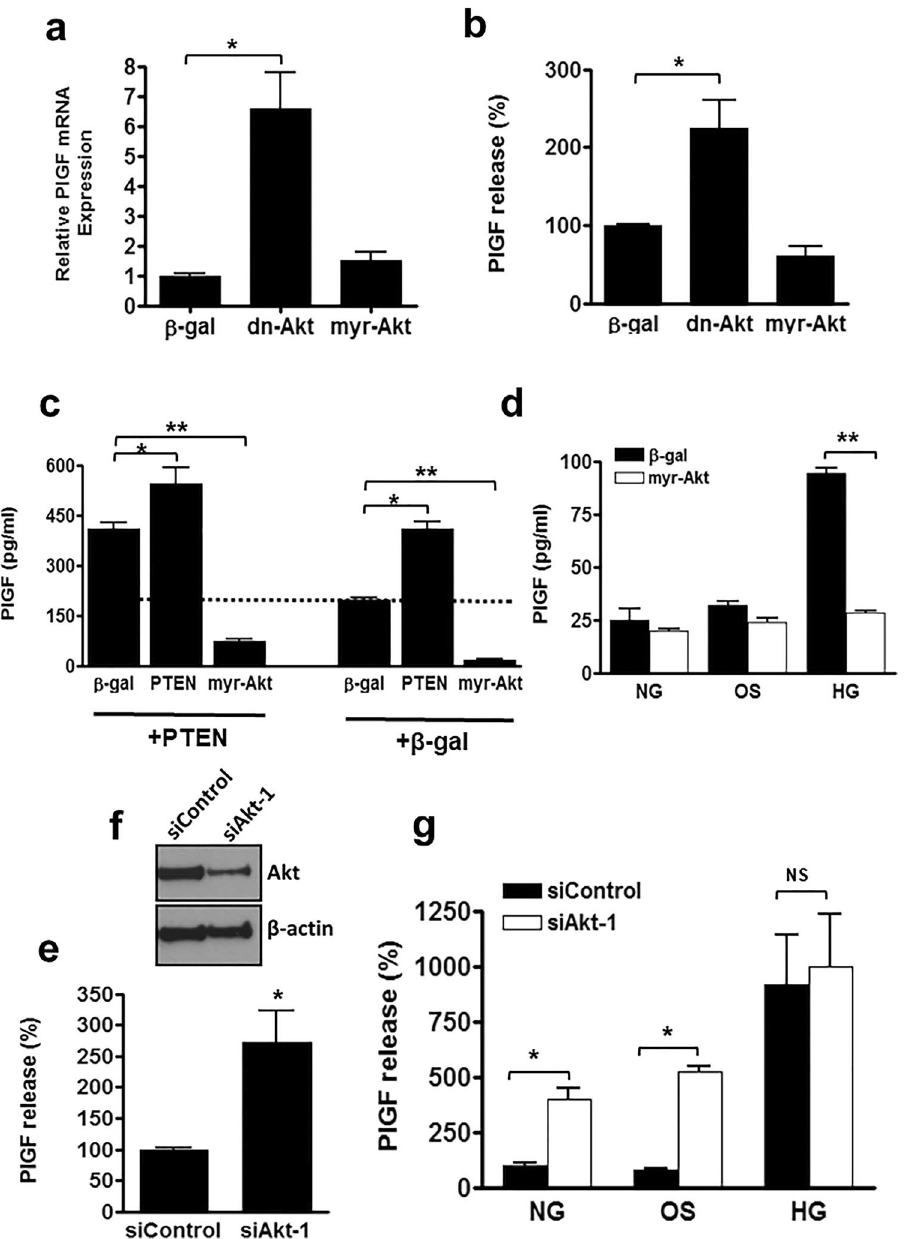
Figure 3. Inhibition of Akt activity increases PlGF production. HUVEC were transduced with adenoviruses encoding dominant-negative Akt (dn-Akt), constitutively active Akt (myr-Akt) and β-galactosidase (β-gal). Following ( a ) 8 h and ( b ) 24-h incubation PlGF expression and secretion was quantified by qPCR and ELISA. ( c ) HUVEC were co-infected with combinations of PTEN, myr-Akt and β-gal (control) adenoviruses overnight. After 24 h PlGF secretion was quantified by ELISA. ( d ) HUVEC were transduced with myr-Akt or β-gal and incubated in normoglycaemia (NG = 5 mM d-glucose), hyperglycaemia (HG = 30 mM d-glucose) or osmolarity control (OS = 5 mM d-glucose + 25 mM l-glucose), and PlGF release into the culture medium measured by ELISA. ( e - g ) HUVEC were electroporated with siRNA targeted to Akt-1 (siAkt) or control siRNA (siControl). ( e ) PlGF measured after 24 h in cell supernatants and ( f ) the cell lysates Western blotted for Akt and β-actin (unedited blot images in Supplementary Figure S5). ( g ) Cells were incubated in NG, HG or OS for 24 h and PlGF release measured by ELISA. Results are the mean ± SEM of 3 or more experiments (n = ≥ 6); Student’s t-test, *P < 0.05, **P <